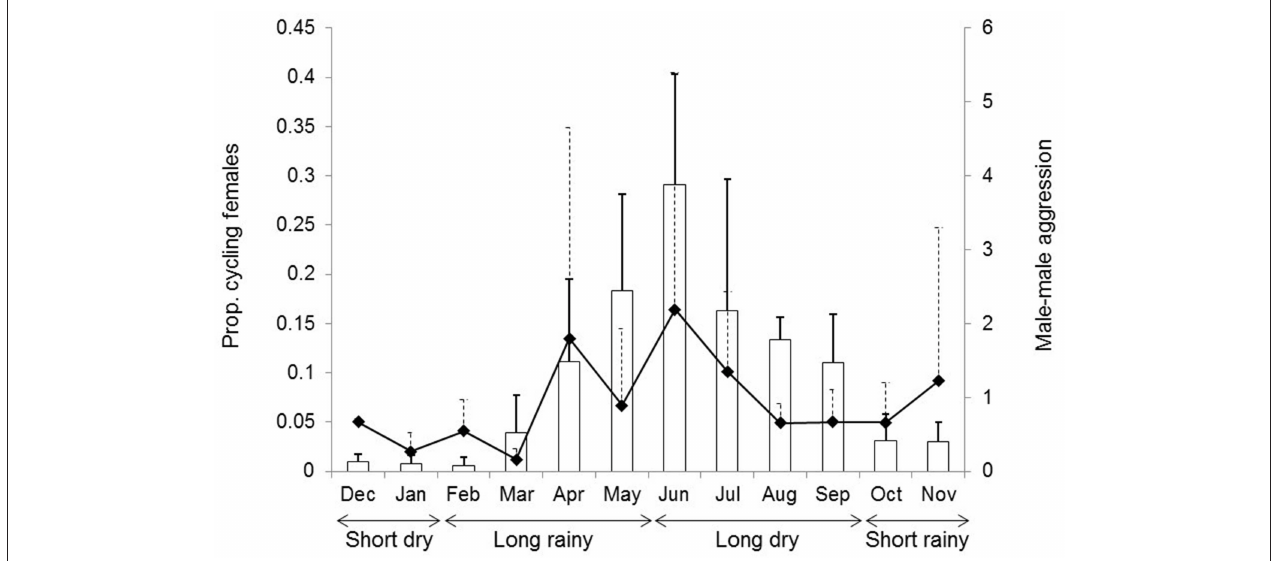
FIGURE 1 | Temporal variation in the proportion of cycling females in the study group (bar plots) and in the rate of male-male aggression during the annual cycle (filled diamonds). In this figure, the monthly proportions of cycling females and the monthly rates of male-male aggression were averaged across the years (mean ± SD are